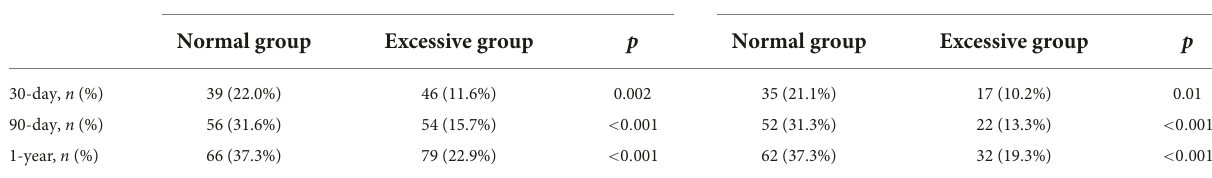
TABLE 2 Outcomes of normal weight group and excessive weight